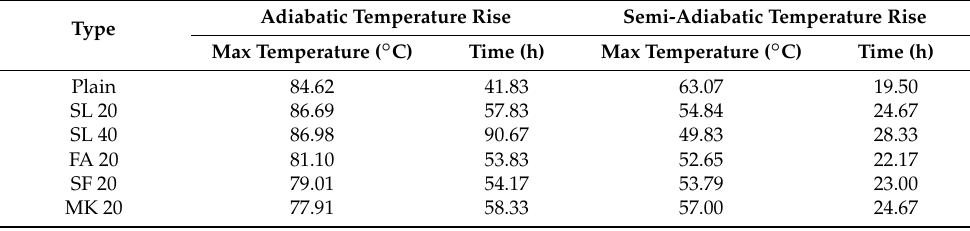
Table 3. The maximum temperatures and times to reach maximum temperatures of concretes tested under adiabatic and semi-adiabatic temperature